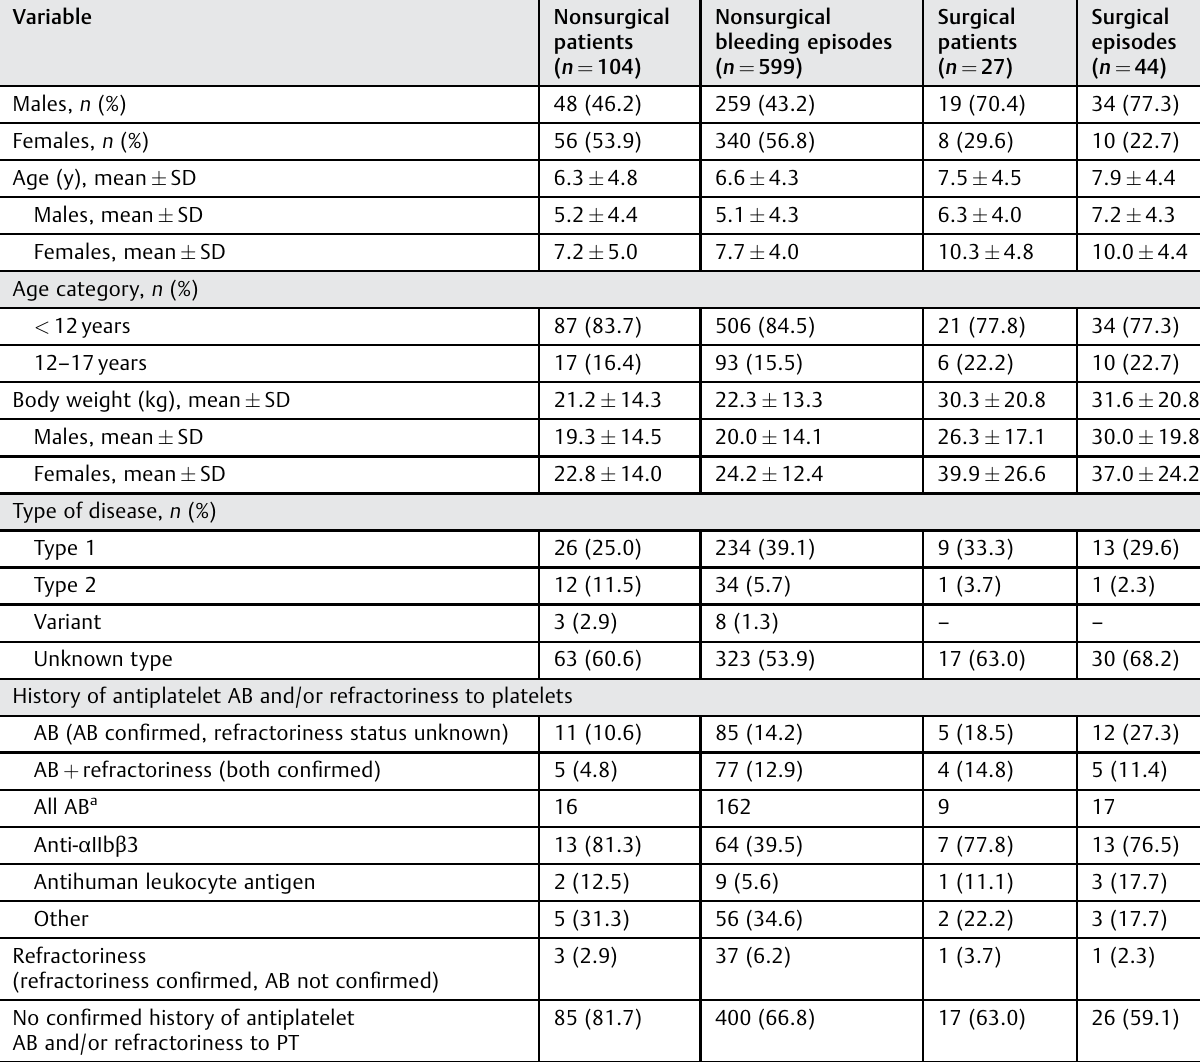
Table 1 Registry: clinical and demographic characteristics of the population < 18 years old at admission